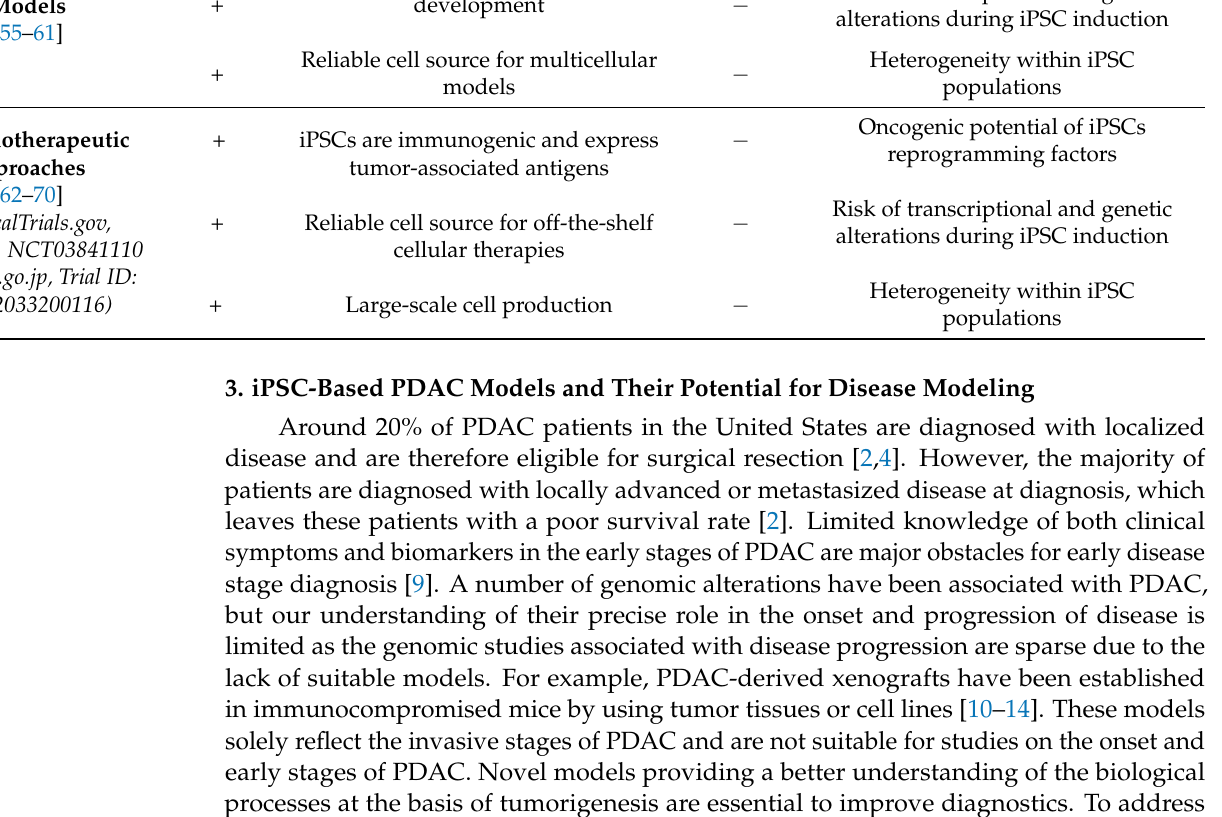
Table 1. Pros and cons of induced pluripotent stem cells (iPSCs) related to cancer immunotherapies and models. Pros + Cons −